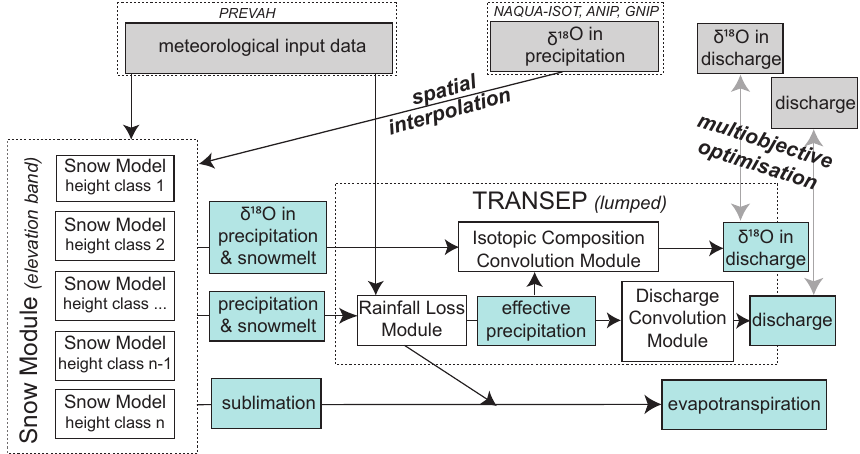
Figure 2. Overview scheme of the model modules. Grey boxes represent input data, blue boxes represent data computed by model modules (white